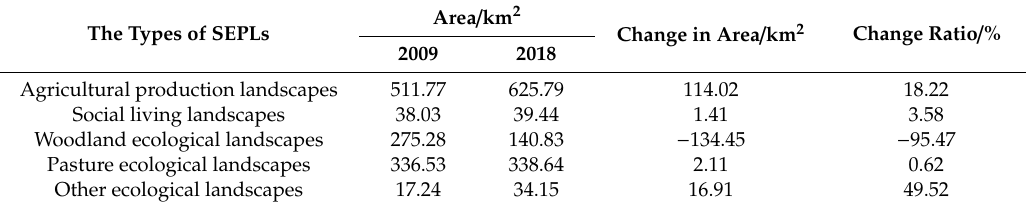
Table 4. Changes in the social–ecological production landscape pattern in Mizhi county from 2009 to 2018.